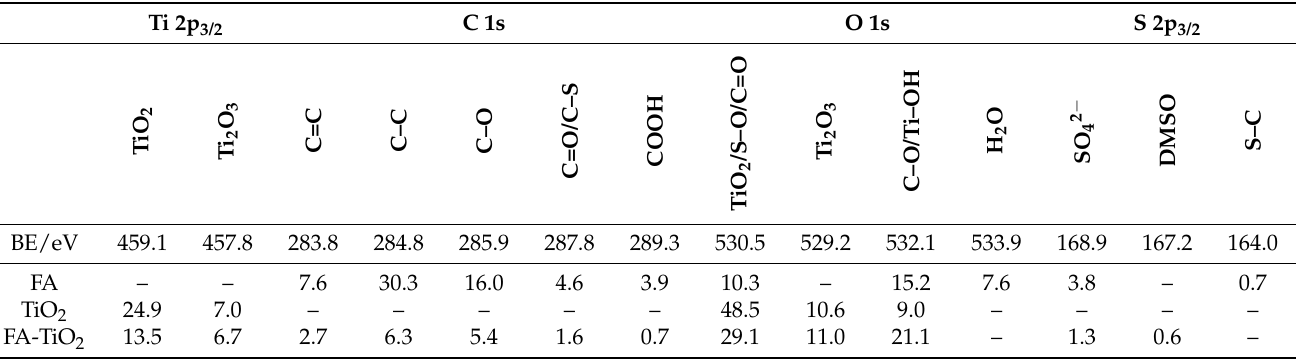
Table 1. The surface chemical composition (at.%) deduced from the high-resolution XPS spectra deconvolution of bare TiO 2 and FA-TiO 2 nanocomposite. Ti 2p 3/2 C 1s O 1s S 2p